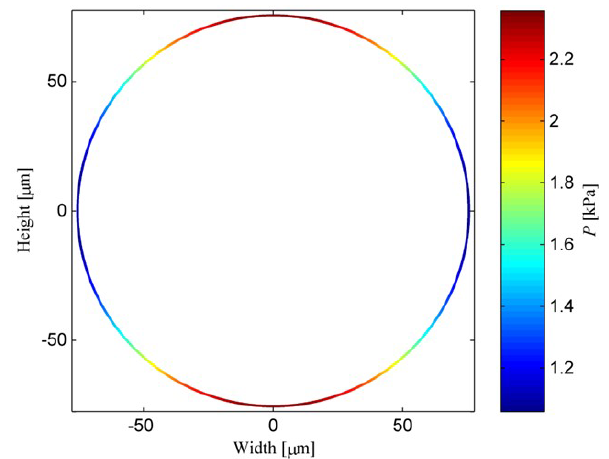
Figure 10. Fluid pressure P for the model shown in Fig. 7, consid- ering a grain diameter d = 150µm and thickness of the interfacial water film a = 1µm. The oscillation frequency is equal to the char- acteristic frequency (1 . 8 × 10 6